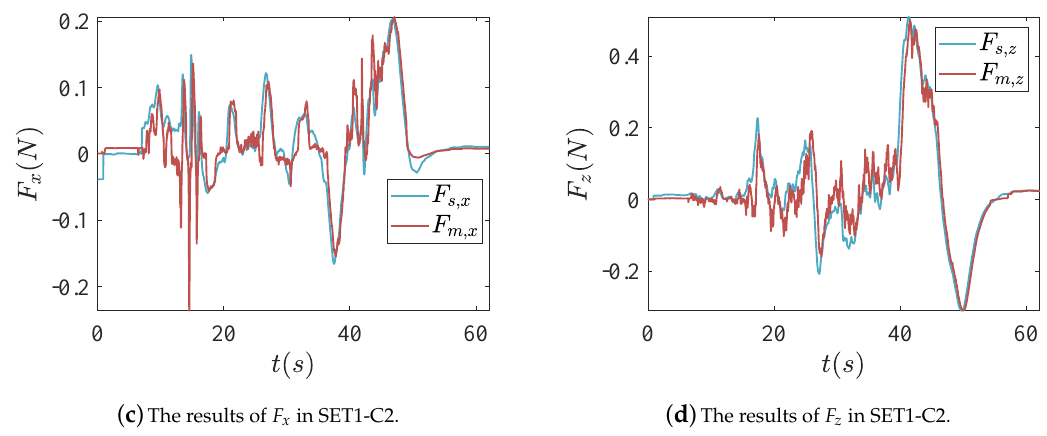
Figure 11. The results of Set1-C2.